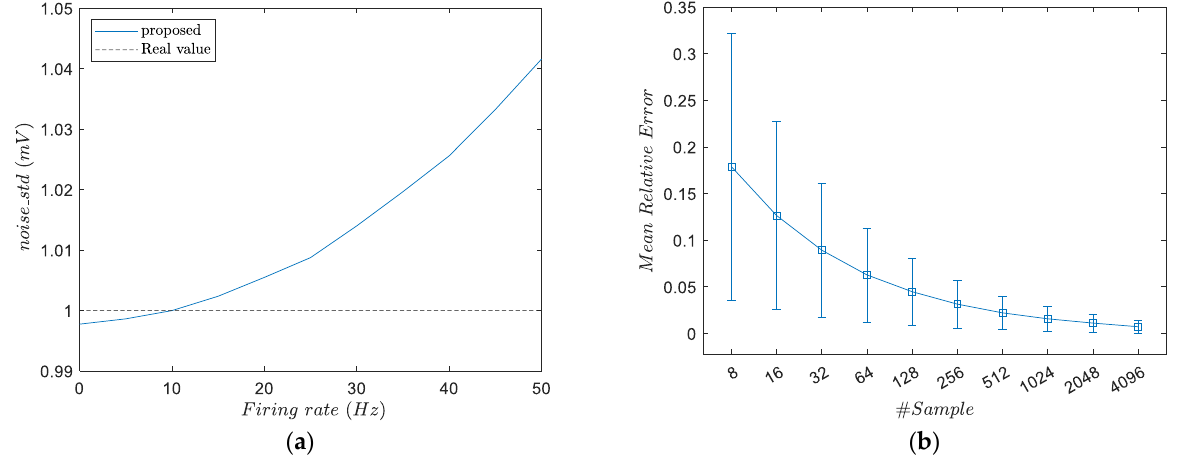
Figure 4. ( a ) Estimation of the noise level. Note how our proposal remained close to the real value ( b ) mean relative error bar plot when determining the noise level over different window length M.